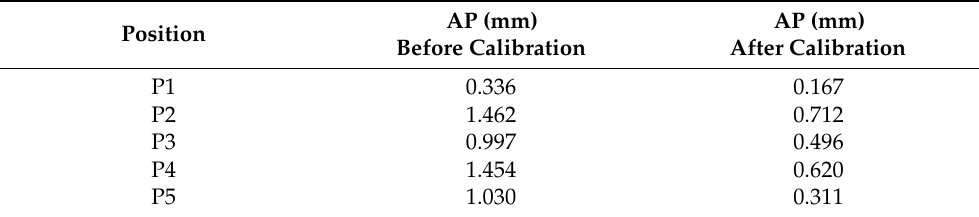
Figure 8. The test cube of the ER20-C10 industrial robot. Table 6. The nominal kinematic parameters of the ER20-C10 robot after